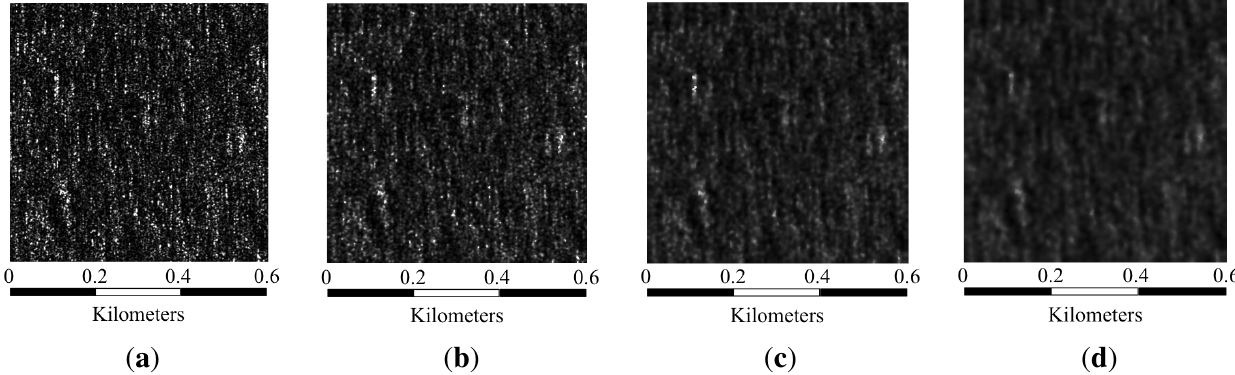
Figure 5. Effect of increasing h on mean shift filtering. ( a ) Patch 3; ( b ) Patch 3 filtered with s = 2 and h = 0 . 5 ; ( c ) Patch 3 filtered with mean shift, h mean shift, h s r = 6 and h = 0 . 5 . ( d ) Patch 3 filtered with mean shift, h s r